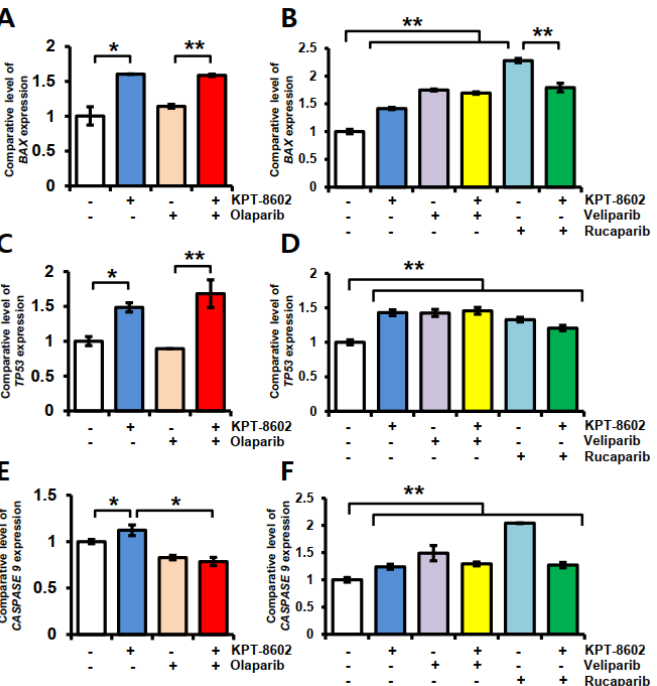
Figure 3. Expression of apoptosis-associated genes in response to KPT-8602 and PARP inhibitors treatment in 22rv1 cells. Gene expression was determined after 24 h of treatment using real-time RT-qPCR. ( A , B ) mRNA expression of BAX ; ( C , D ) mRNA expression of TP53 and ( E , F ) mRNA expression of CASPASE 9 . All experiments have been done at least three times. Error bars represent standard deviation. * p < 0.05; ** p < 0.01.